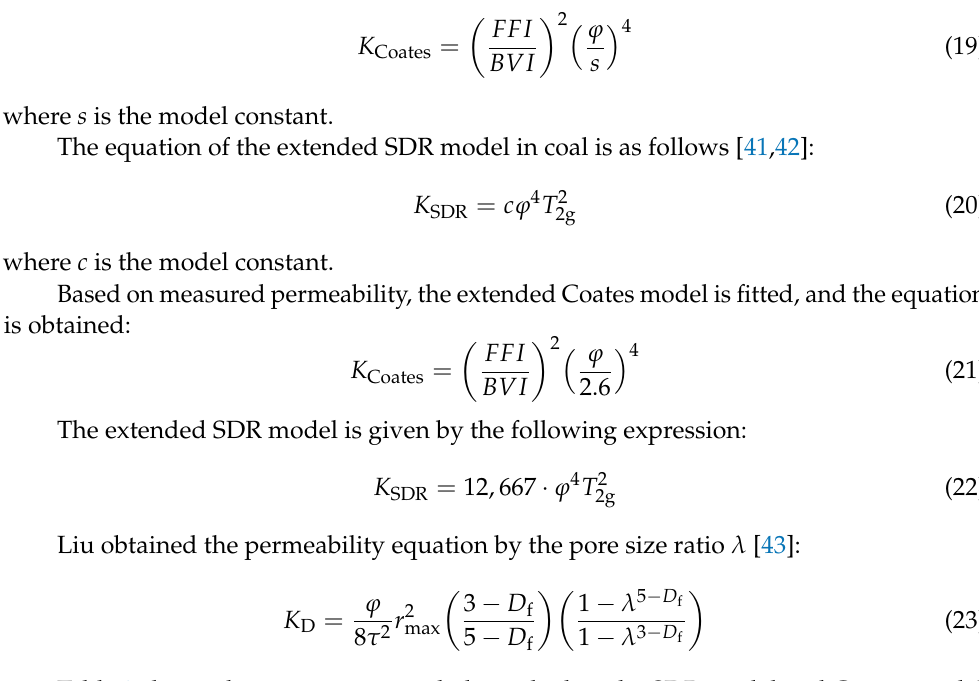
Figure 10. The water content of pores.